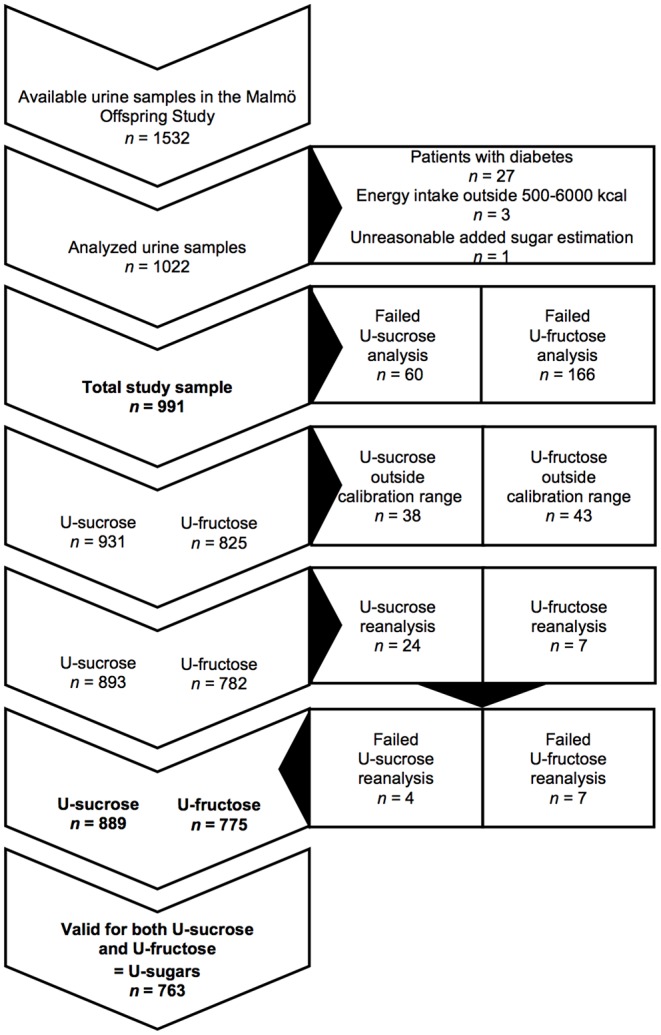
Flow chart of participants and urine samples in the Malmö Offspring Study. U-sucrose, urinary sucrose; U-fructose, urinary fructose; U-sugars, sum of urinary sucrose and fructose.